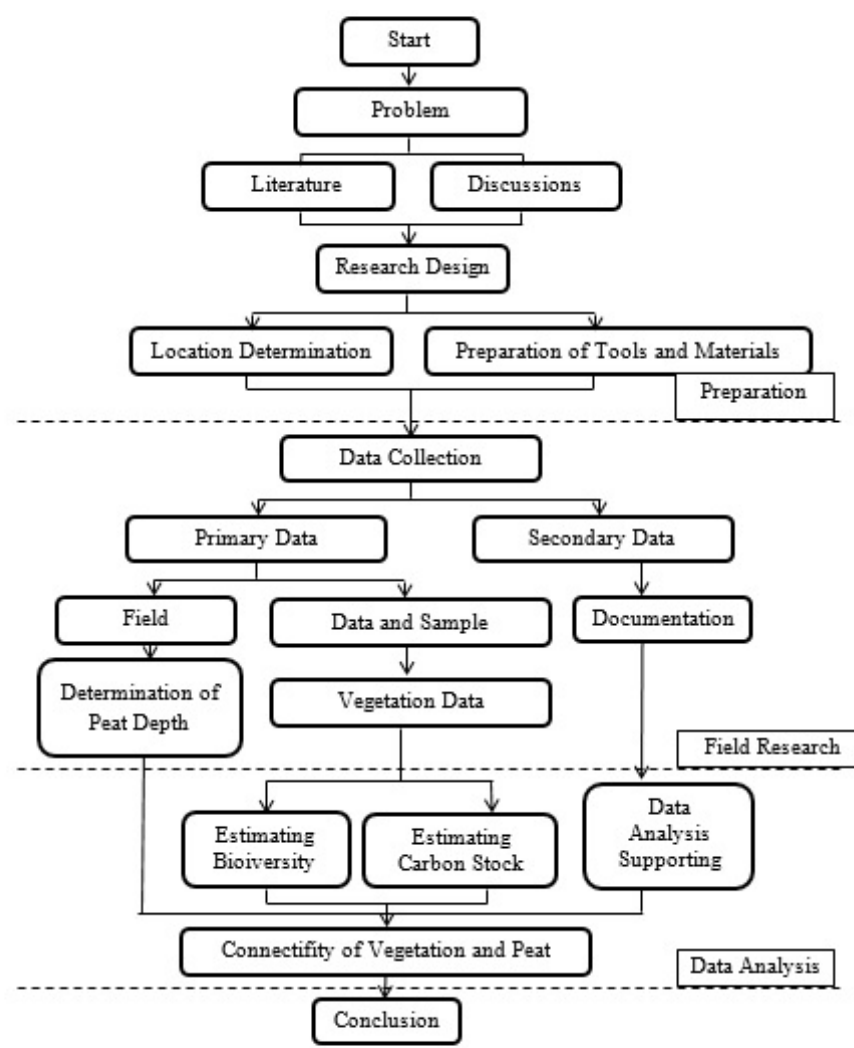
Fig. 2: Flow diagram for the overall methodology